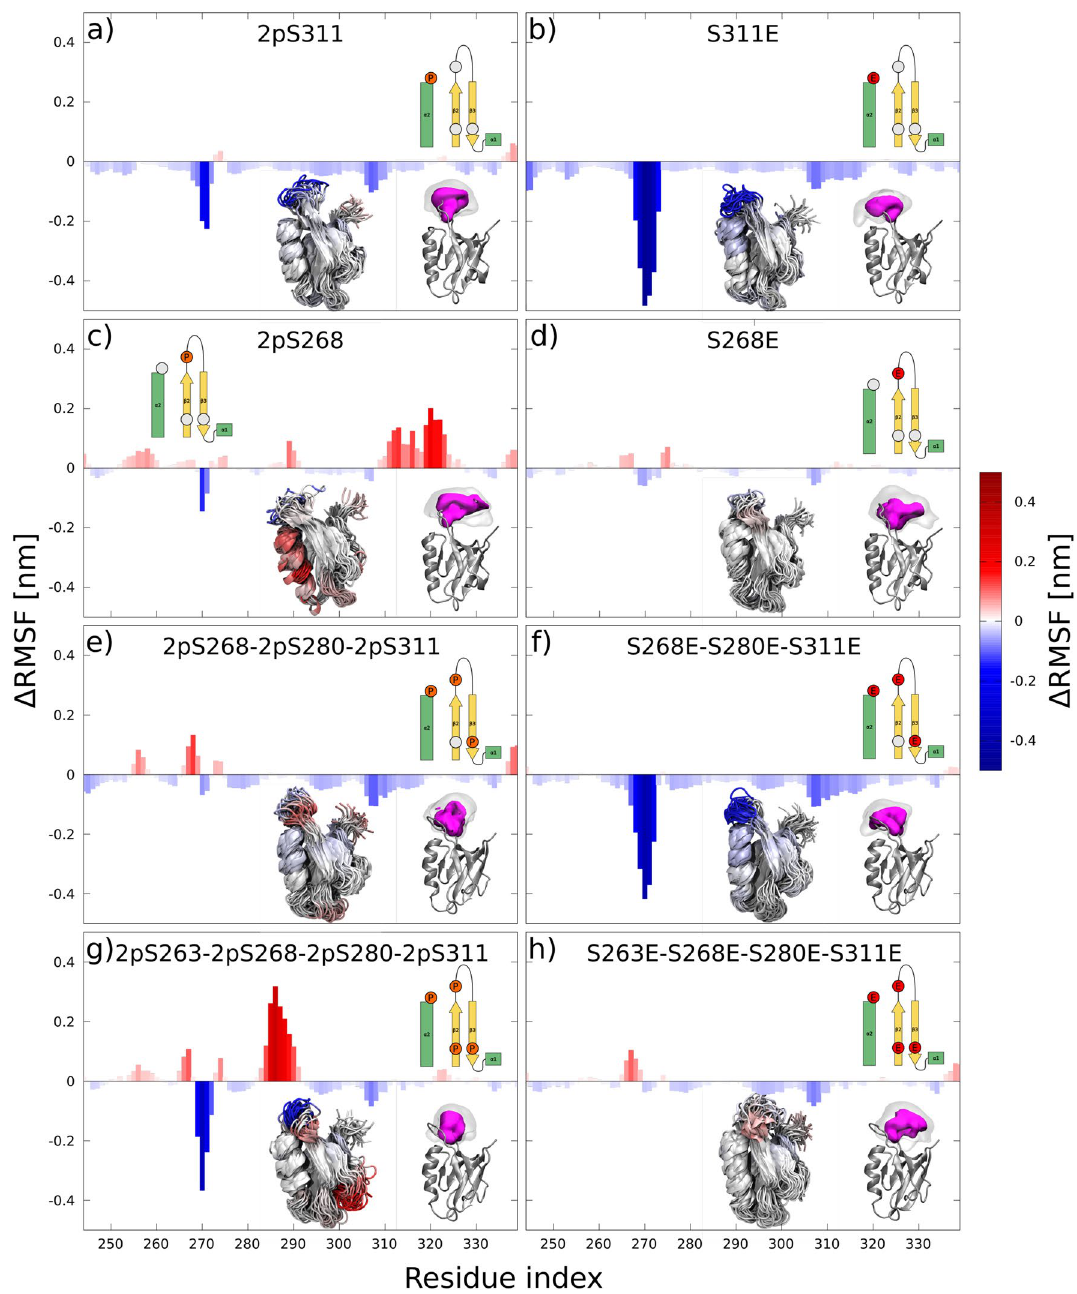
Figure 5. Phospho/mimetics discrepancy in multi-phosphorylated PDZ. Changes in PDZ fluctuations ( (cid:31) RMSF) caused by phospho/mimetic variants. Positive values (red) and negative values (blue) corresponds to an increase and decrease in RMSF compared to PDZ wt, respectively. ( a , c , e , g ) and ( b , d , f , h ) corresponds to phospho and mimetic variants, respectively. Schematic representation of the system according to Fig. 1 is shown in the top part of each figure. A bundle of simulation snapshots colored according to RMSF change and a picture of the volume occupied by the loop β 2 – β 3 (for color coding see Fig. 2) are displayed in the bottom left and right,